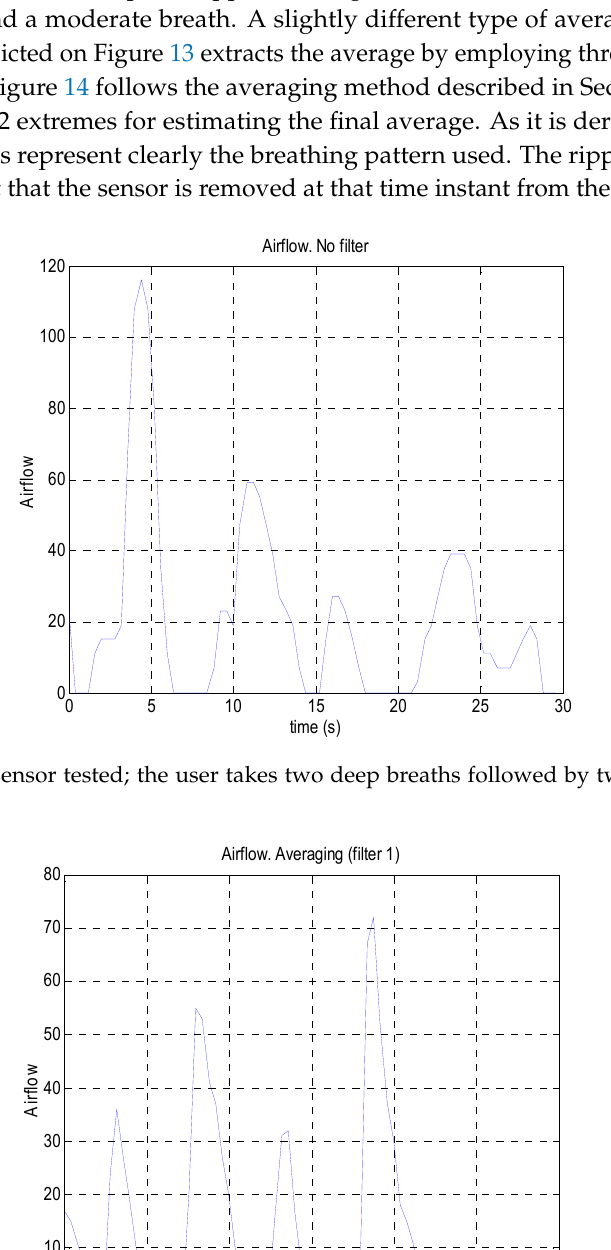
Figure 14. Airflow sensor tested; the user alternately takes a deep and a moderate breath. Filter type 2 was applied. The EMG sensor’s results are shown in Figures 15 and 16. In Figure 15 a relatively small sampling period of 200 ms was used with no filtering. A moderate muscle contraction is followed by a strong and then a small one. Although an intense rippling appears, the muscle contraction pattern is recognizable. The same muscle contraction pattern is used in Figure 16 with a longer sampling interval of 1sec that allows the various filtering types to be applied. The reduced rippling allows the three muscle states to be recognized more clearly when averaging is used and especially when Filter type 2 , of subsection 2.2, is applied.